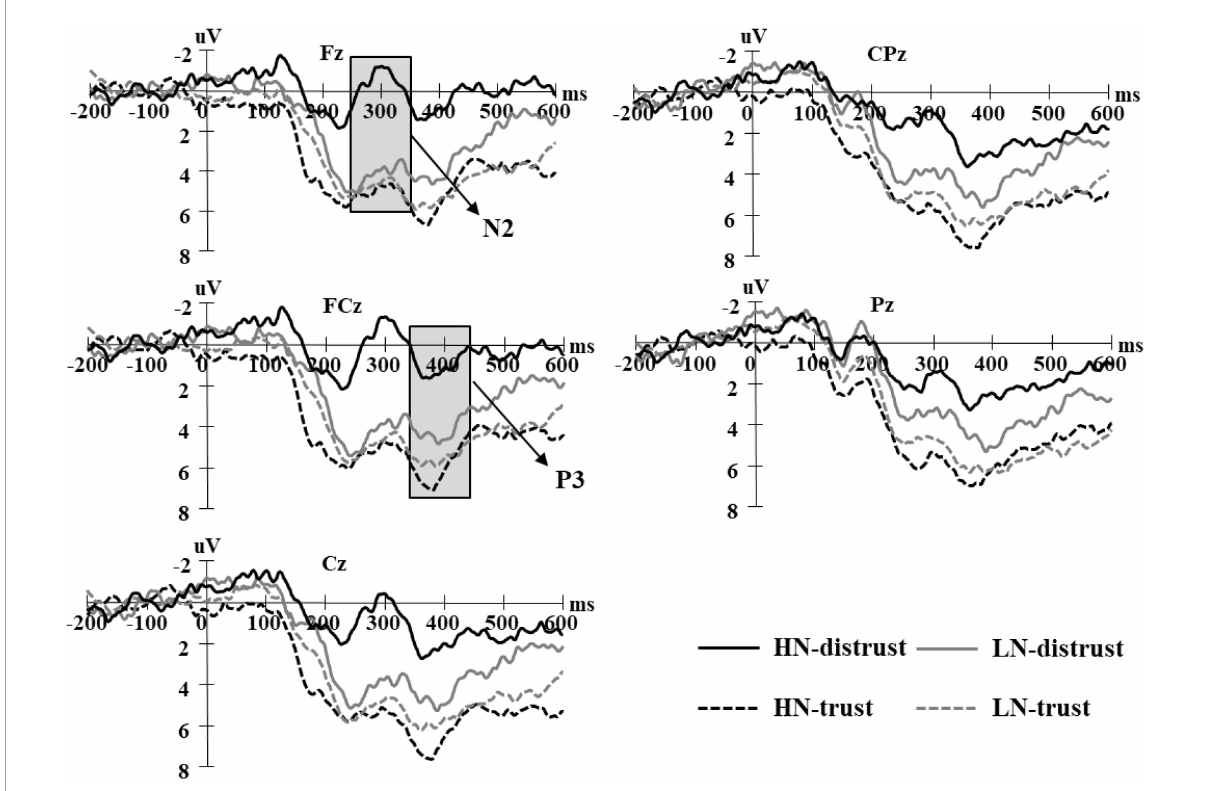
FIGURE2 Grand average waveform for trusting and distrusting decision, separated by high narcissism (HN).